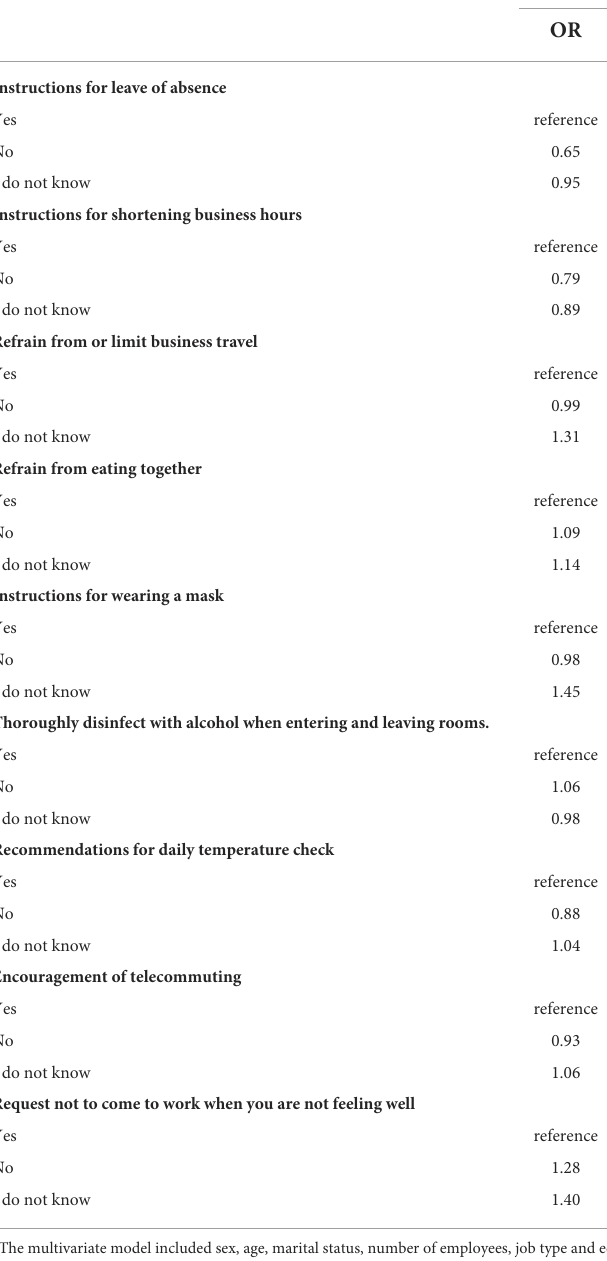
TABLE 3 Association between psychological distress and instructions from the working place regarding infection control. Univariate Multivariate* OR 95% CI